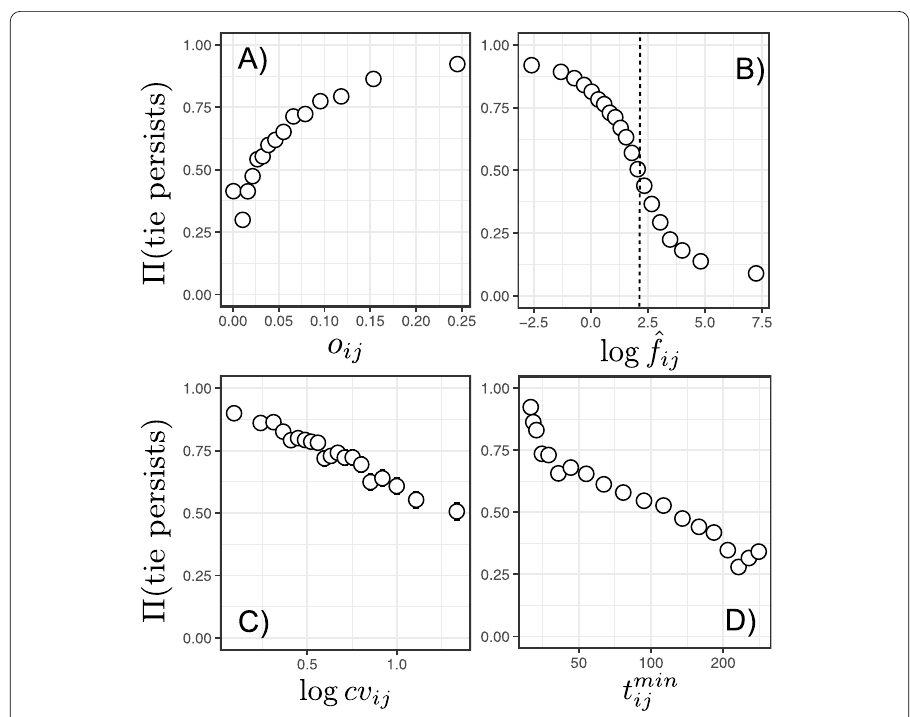
Figure 2 Impact of some features on tie persistence. Conditional probability of persistence as a function of the different variables of the tie: (A) topological embeddedness, (B) relative freshness, (C) coefficient of variation and (D) time of the first call in our database. In (C) only ties with w ij ∈ [20,50] are considered. The vertical line in (B) indicates the critical relative freshness ˆ f ij = 8.33, where (cid:5) = 1/2. Error bars are showed when they are bigger than symbol